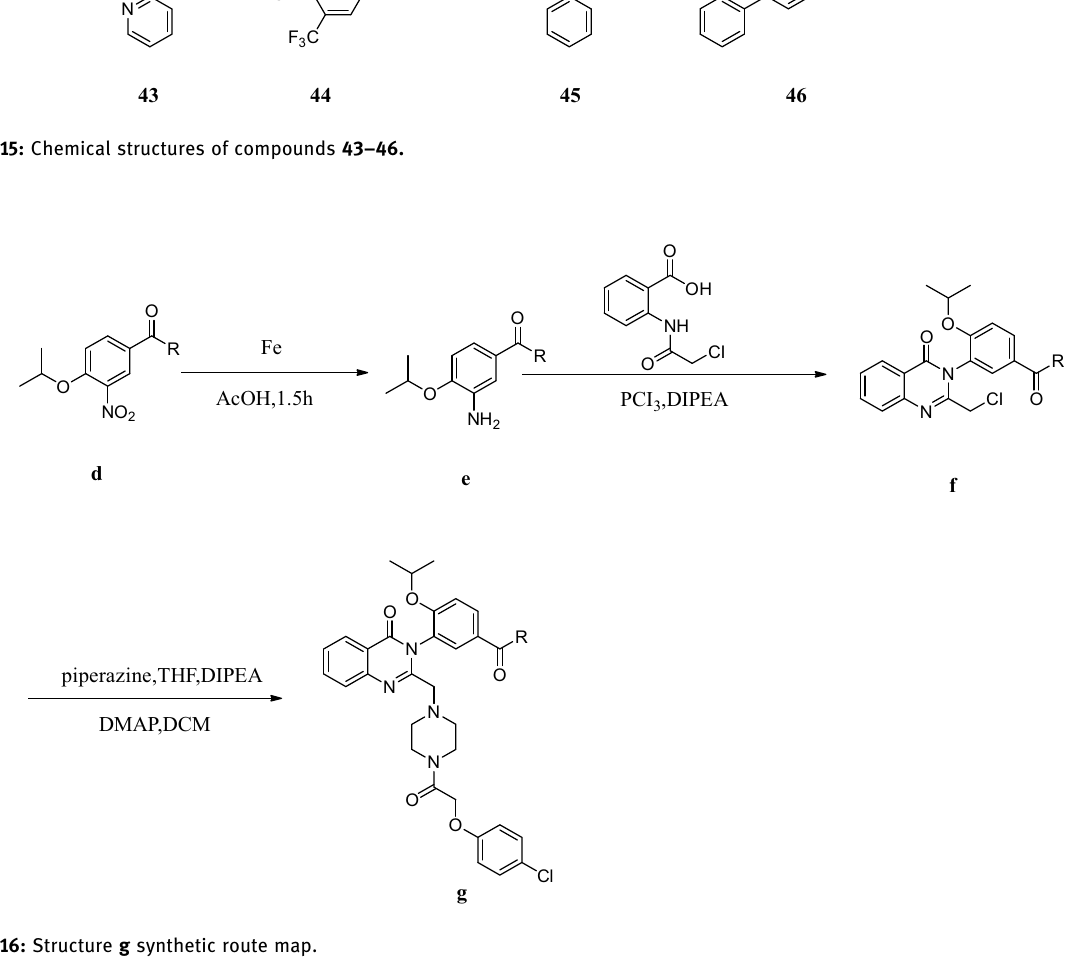
Figure 16: Structure g synthetic route